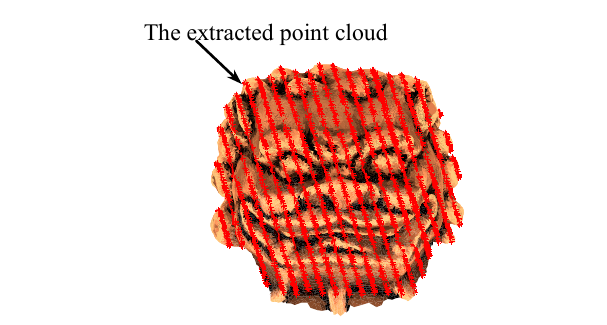
Figure 12. Diagram illustrating registration result of Chinese lion head model and the extracted point cloud. Table 1. Recognition data ( D max [mm]).